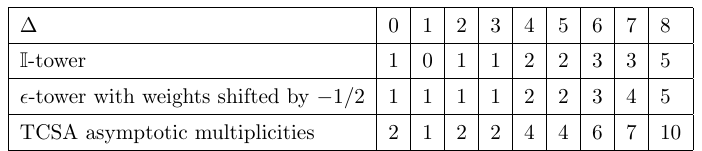
Table 7. Observed multiplicities of the large coupling (cid:12)xed point with integer (cid:1) max